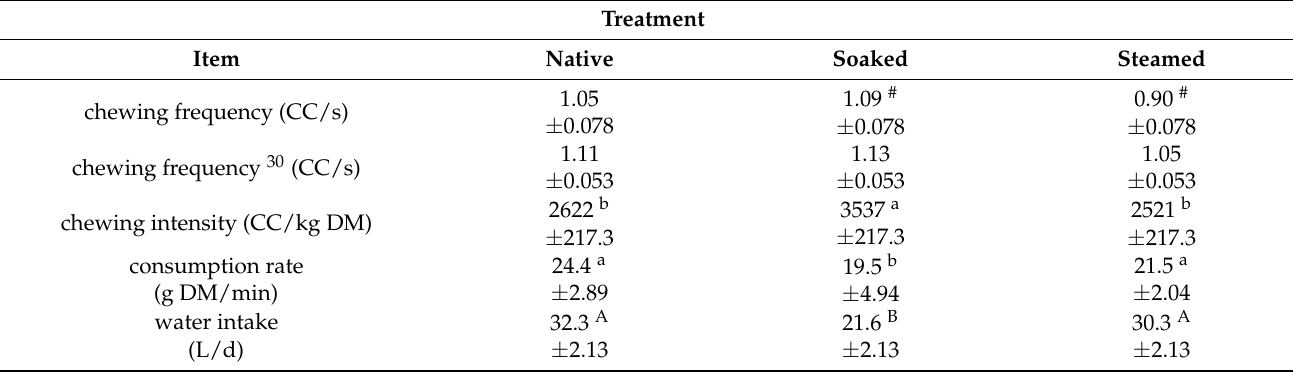
Table 5. LSmeans ( ± SE) of chewing parameters and water intake (L/d) in horses after feeding native, soaked and steamed hay. Treatment Item Native